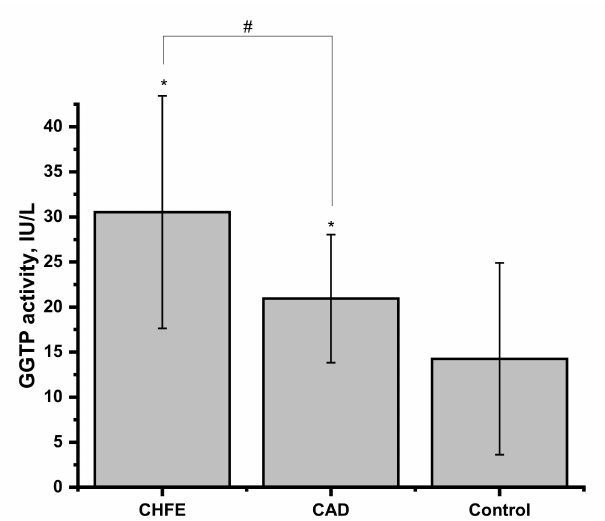
Figure 5. The assessment of γ -glutamyl transpeptidase (GGTP) activity in human plasma from CHFE ( n = 7), CAD ( n = 8) and control ( n = 15) participants. All results are reported as the average of three-fold repeated measurements and the data represents mean ± SD. The values of * p < 0.05, were considered significant; # p > 0.05. Table 2. Pearson’s correlation coefficient between γ -glutamyl transpeptidase (GGTP) activity and GSNO decomposition measured in neat blood plasma samples (blank) or supplemented with